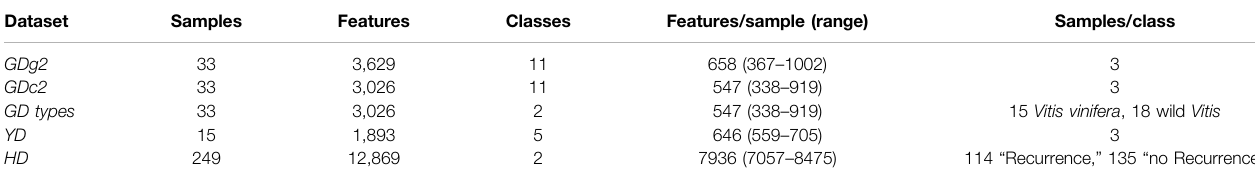
TABLE 1 | General characteristics of the different benchmark